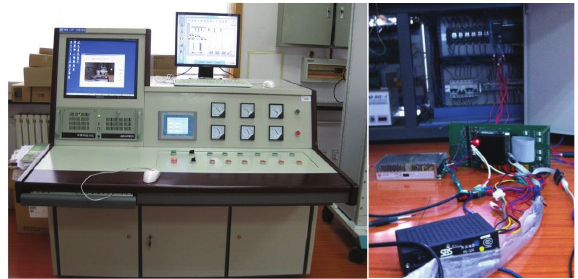
Figure 15: Practical HIL Simulation Platform and the Embedded Controller.